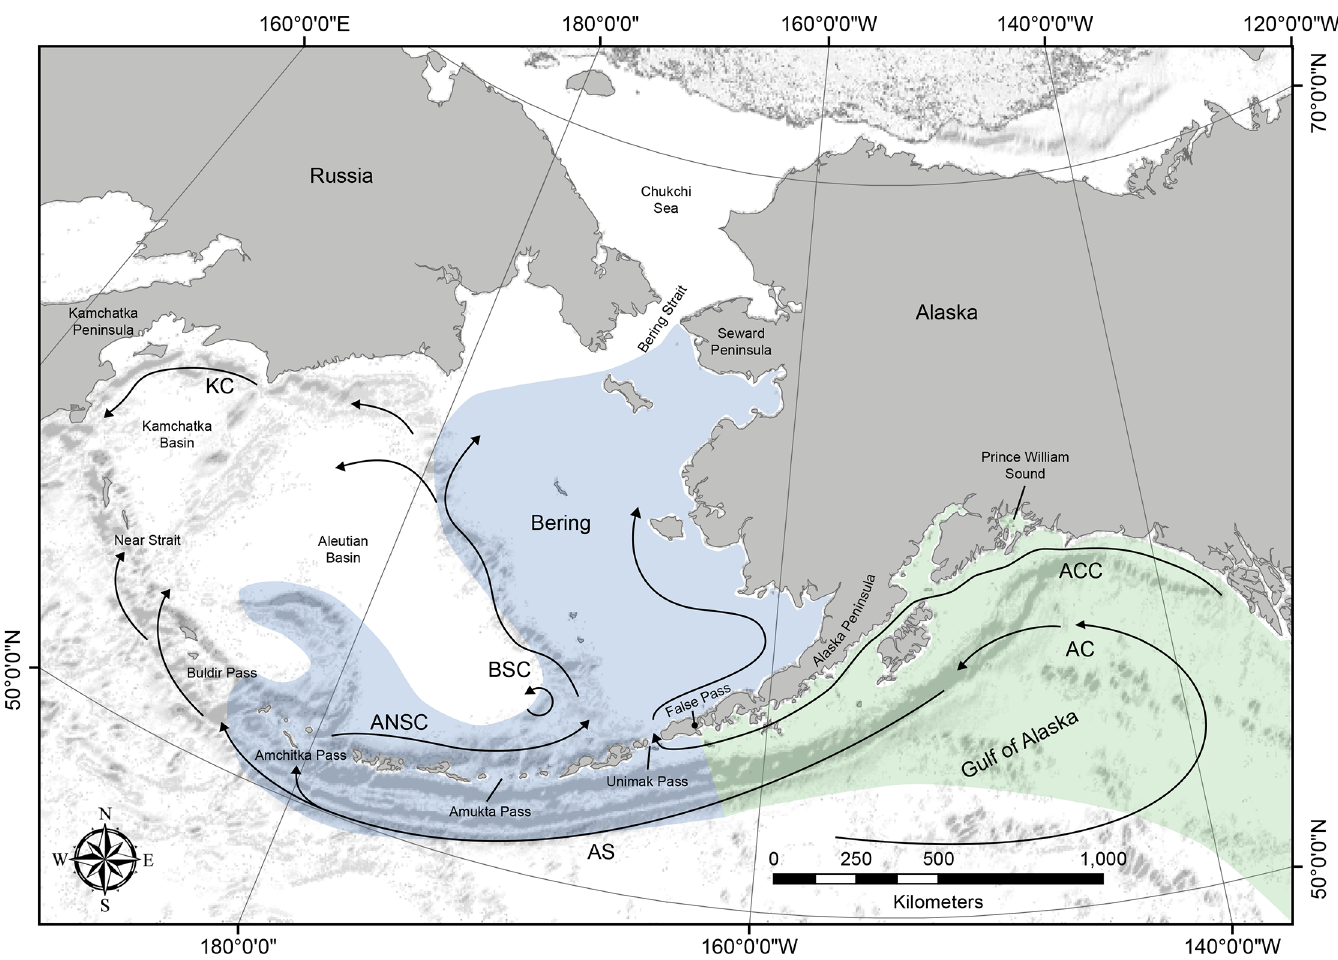
Fig 1. Major prevailing ocean currents and passes in the Aleutian Islands, within the EBS- and GoA-LMEs. The EBS-LME is shown in blue; the GoA-LME is shown in green. Major currents are the Alaska Current (AC), Alaska Coastal Current (ACC), Alaska Stream (AS), Aleutian North Slope Current (ANSC), Bering Sea Current (BSC), and Kamchatka Current (KC). Gray areas in the water indicate trenches. Ocean current data are compiled, but not identical to, figures from Stabeno and Reed [30,31]. The base map was produced using ArcGIS version 10.2.2